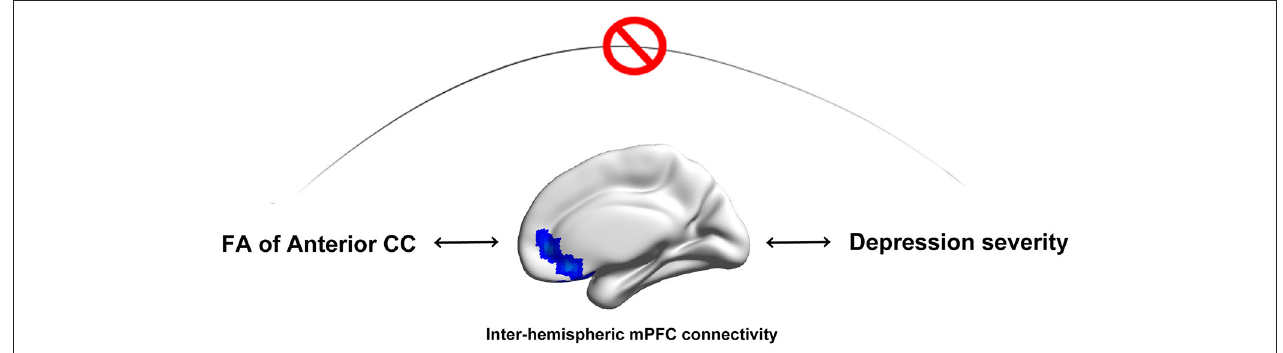
FIGURE 5 | Anterior CC microstructural integrity has an indirect influence on depression severity in MDD patients. Disruption of anterior CC microstructural integrity has an indirect impact (through exerting effects on FC of the bilateral medial prefrontal cortex) on depression severity in MDD patients.